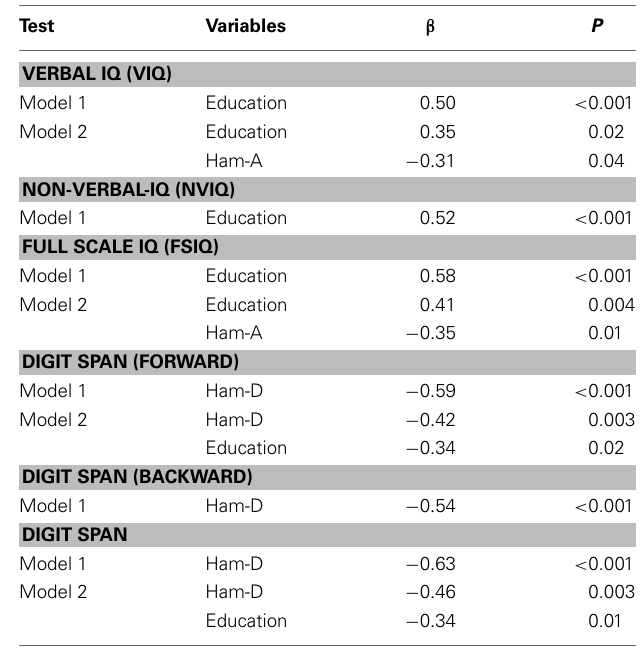
scores, with the combination of these factors accounting for 47% of the variance in the change in identification task response time. Performance in the one card learning task was not influenced by